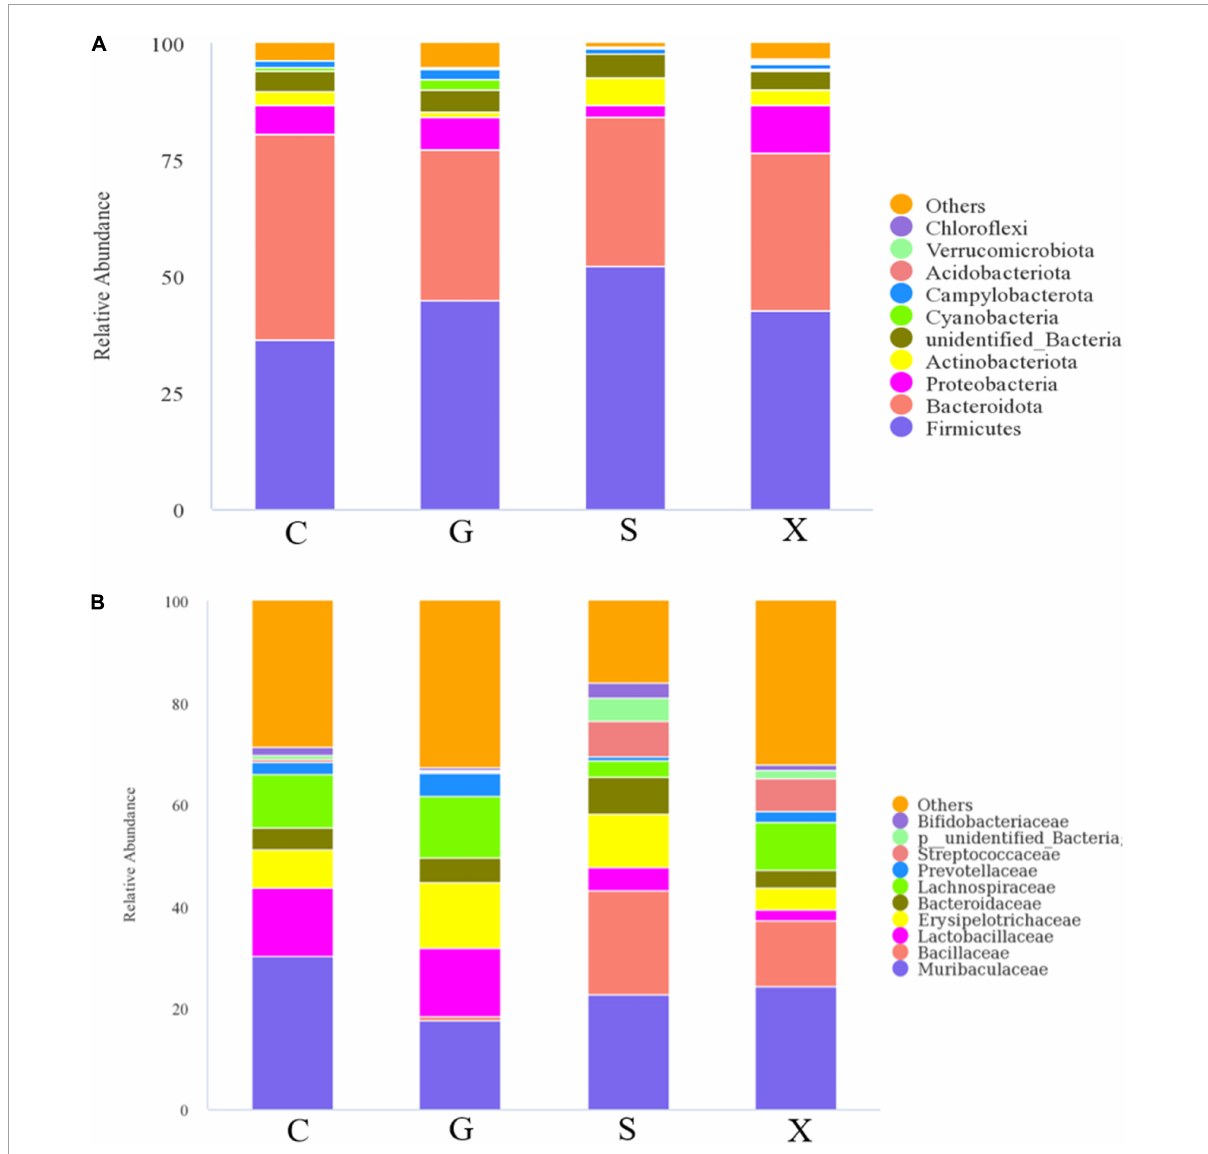
FIGURE6 The intestinal microbiota composition changes of mice with reactivation of Toxoplasma gondii at 7 dpi. C: no T. gondii + DEX + PBS; G: 3 T. gondii cysts + DEX + PBS; S: 3 T. gondii cysts + DEX + koumiss; X: 3 T. gondii cysts + DEX + mare’s milk. (A,B) Indicate phylum and family levels, respectively. All data are expressed as mean ±